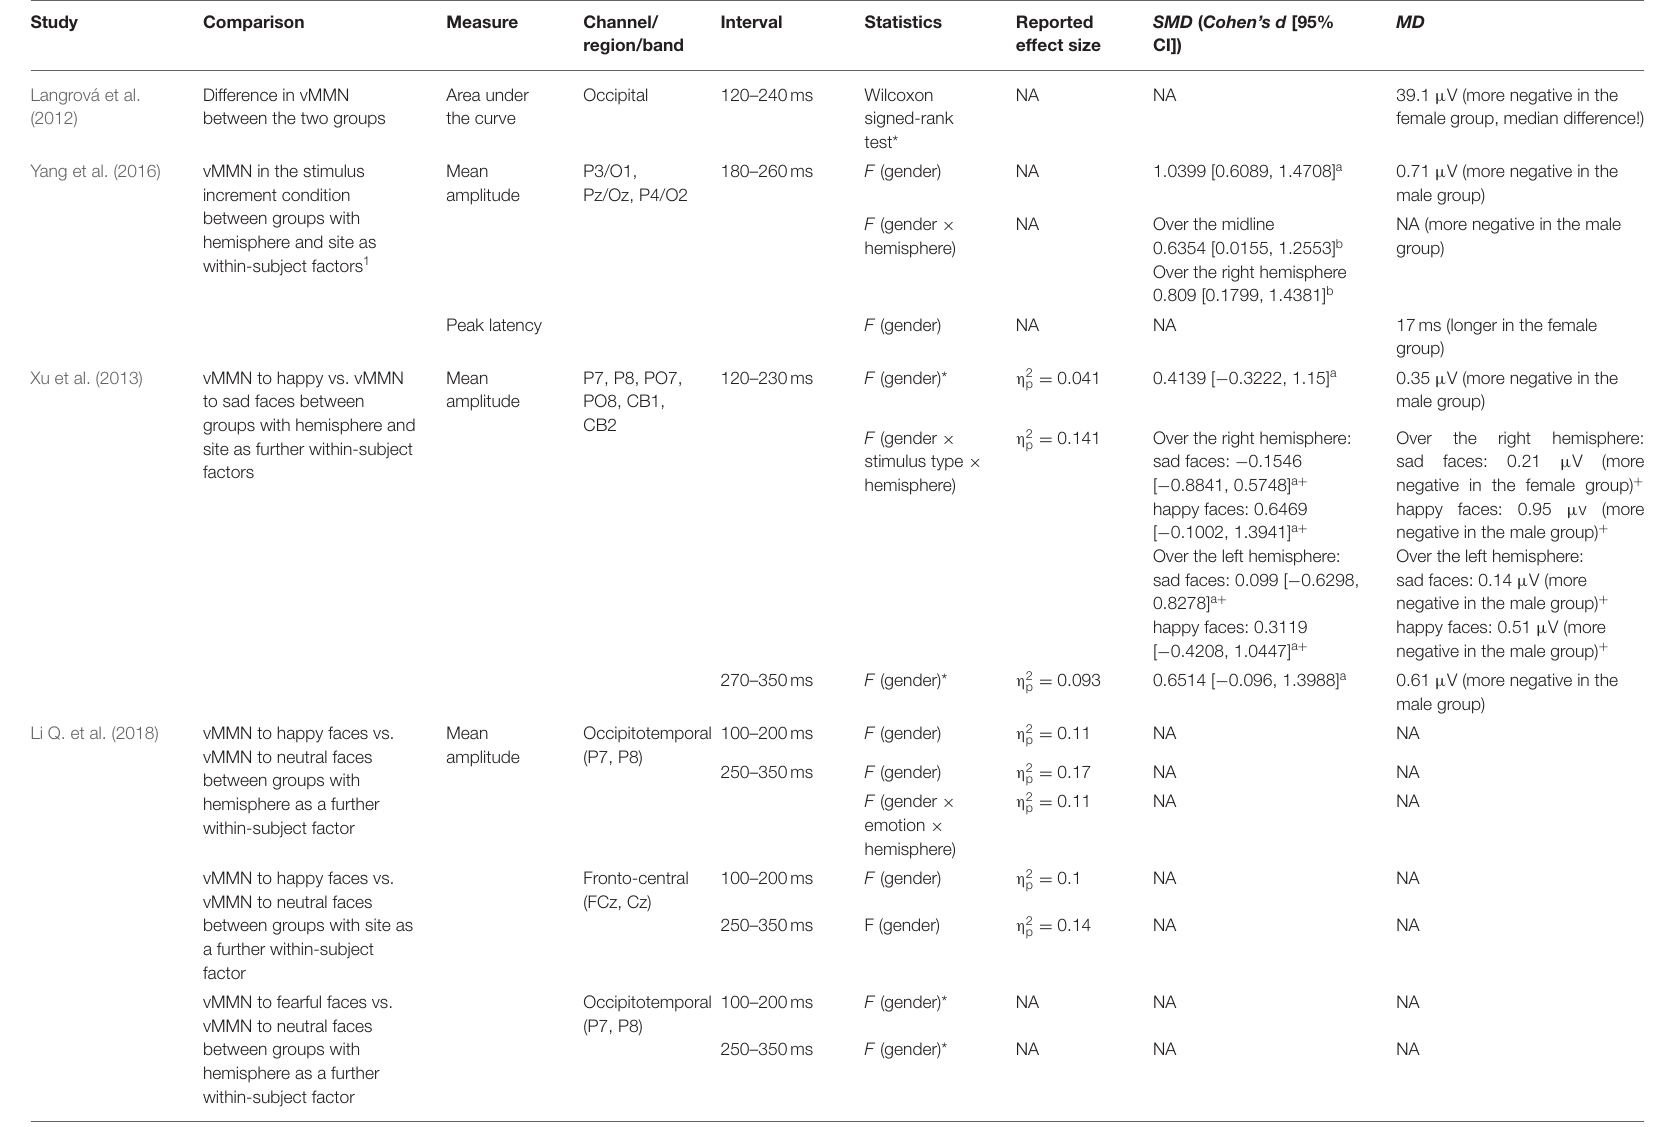
TABLE 2 | A summary of the effect sizes for intergroup comparisons in the review studies.